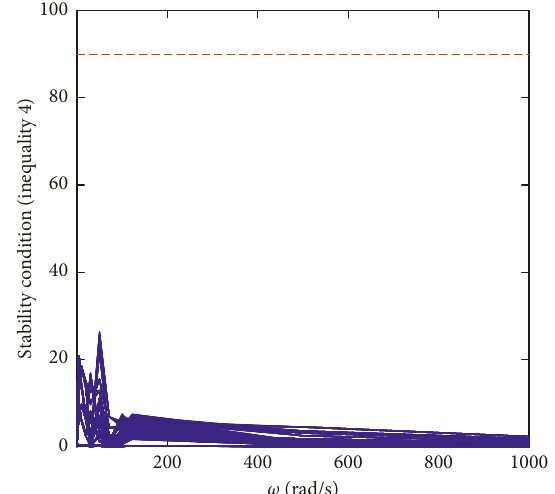
Figure 6: Stability condition (inequality 4) for the switching controller.